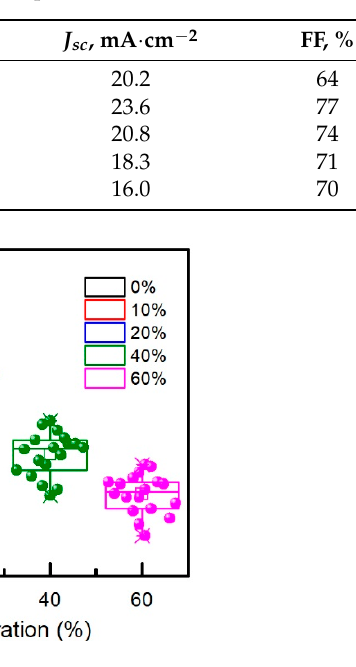
Figure 12. Statistical distribution of power conversion efficiency of perovskite solar cells versus Cs concentration. Error bars indicate plus or minus one standard deviation from the mean.